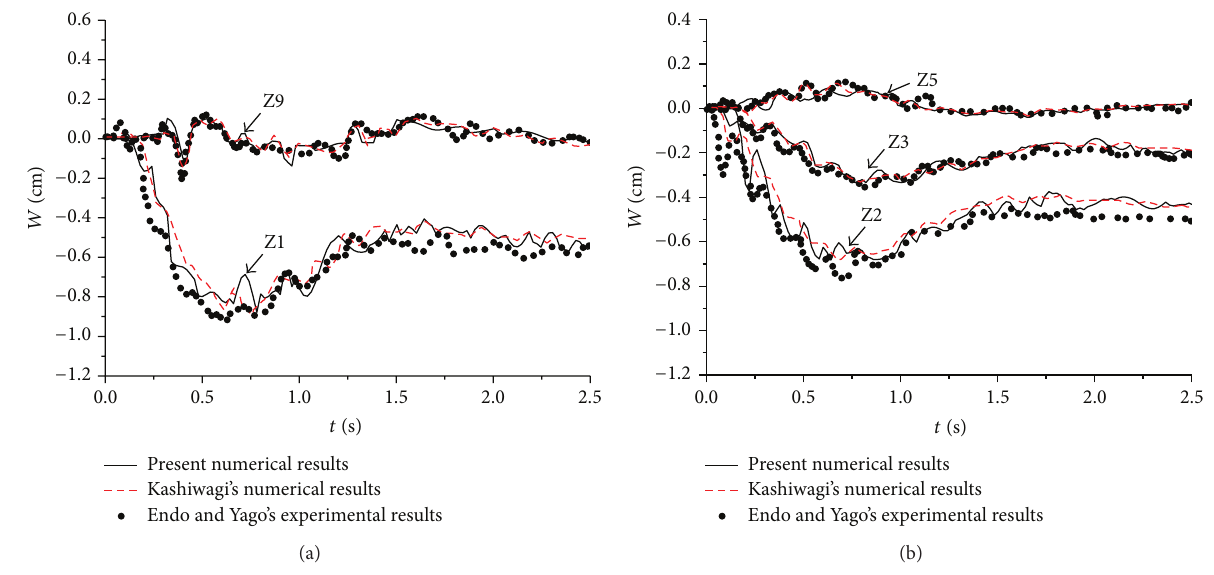
Figure 7: Comparison of time histories of the vertical displacement at each measured point.